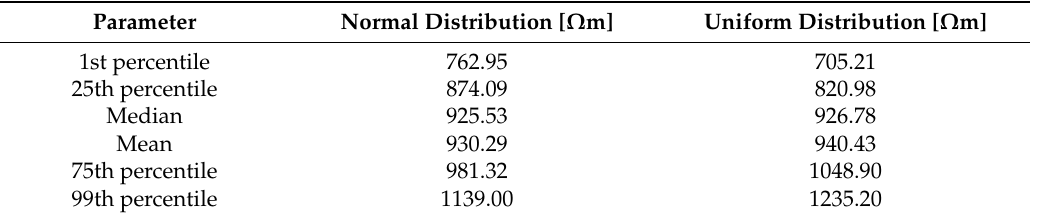
Table 2. Statistical parameters of the two tested distributions (normal and uniform) for the randomly selected quadripole 759 (A:15; B:17; M:21; N:23) acquired with an input voltage of V AB = 800 V which apparent resistivity is 926.625 Ω m.